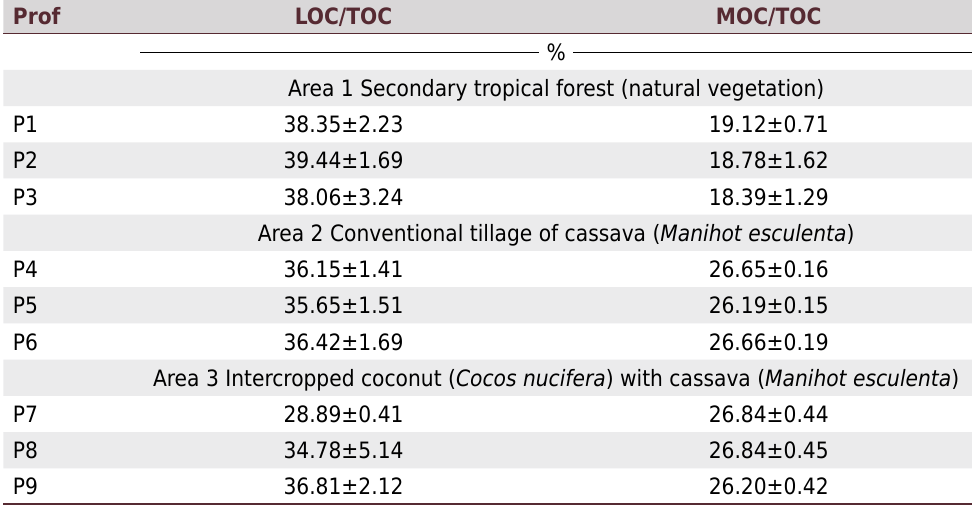
Table 6. Ratios of labile organic carbon (LOC) and mineral-associated organic carbon (MOC) over total organic carbon (TOC) Prof LOC/TOC MOC/TOC